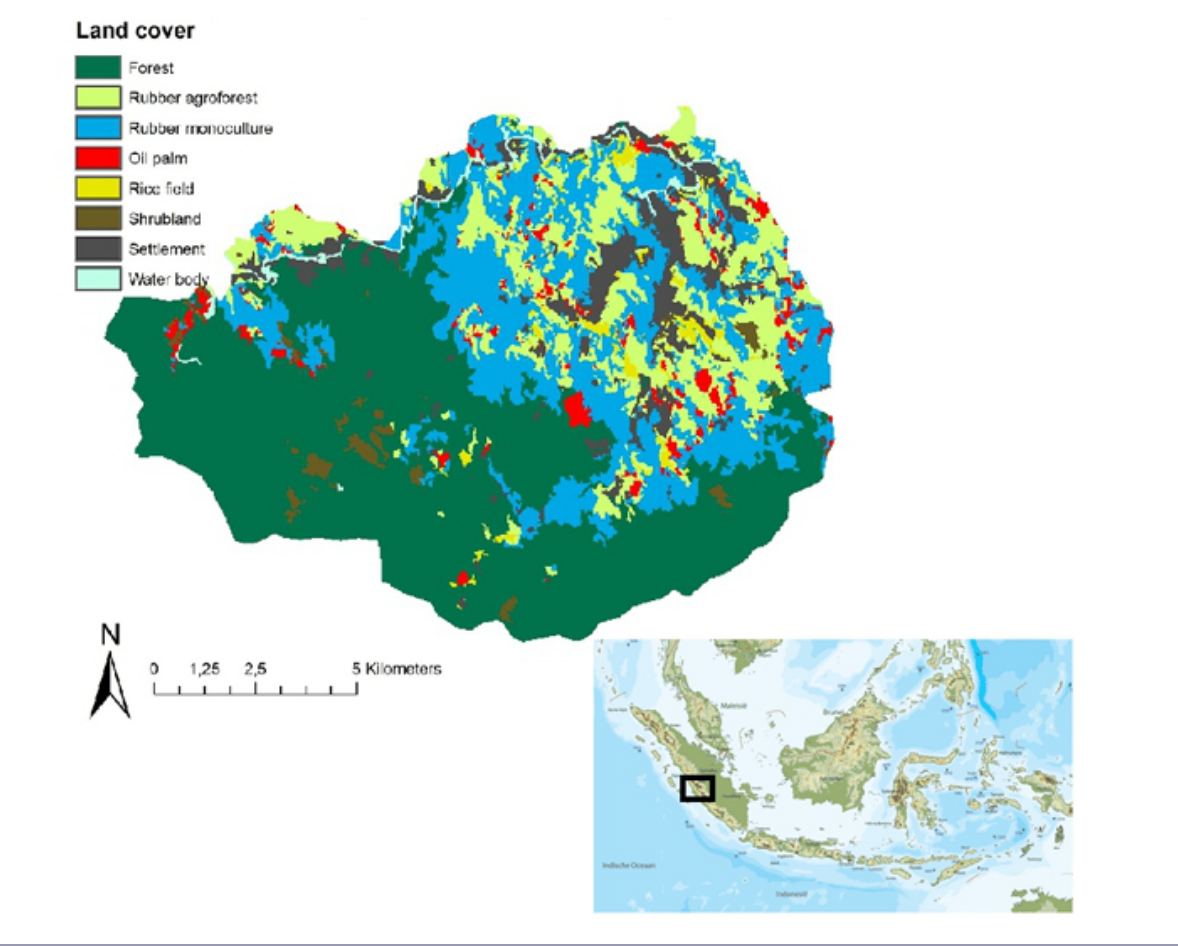
Fig. 3. Map of the study site (Bungo district), Jambi Province,